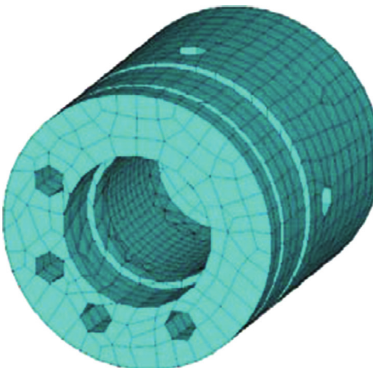
Figure 8: Bush model and